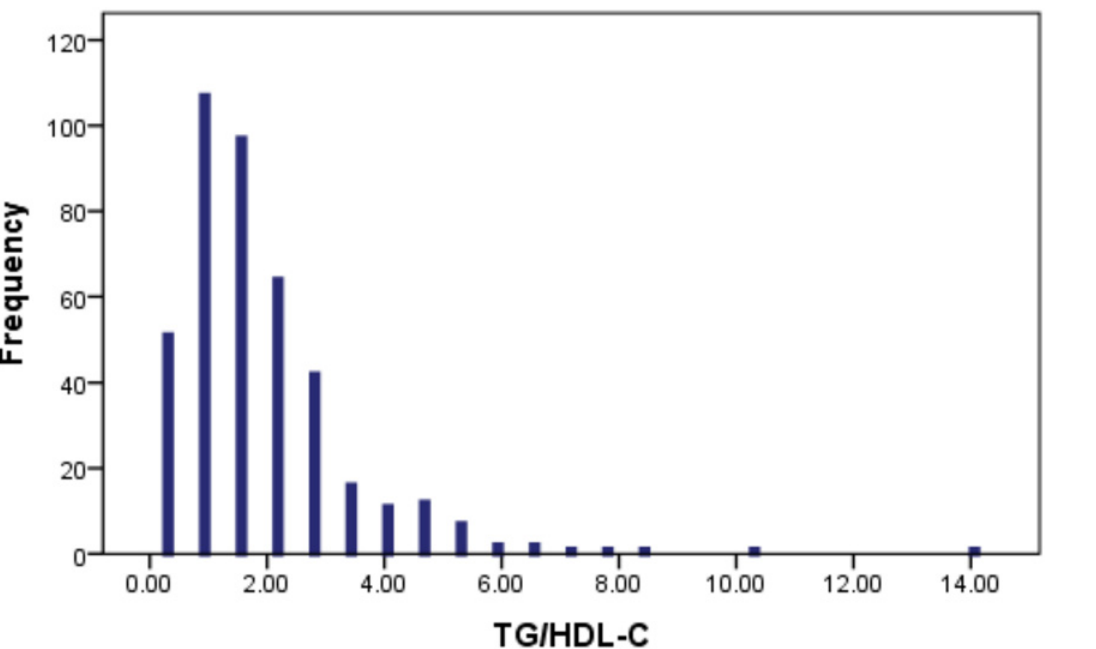
Fig 2. Distribution of the TG/HDL-C ratio in the study